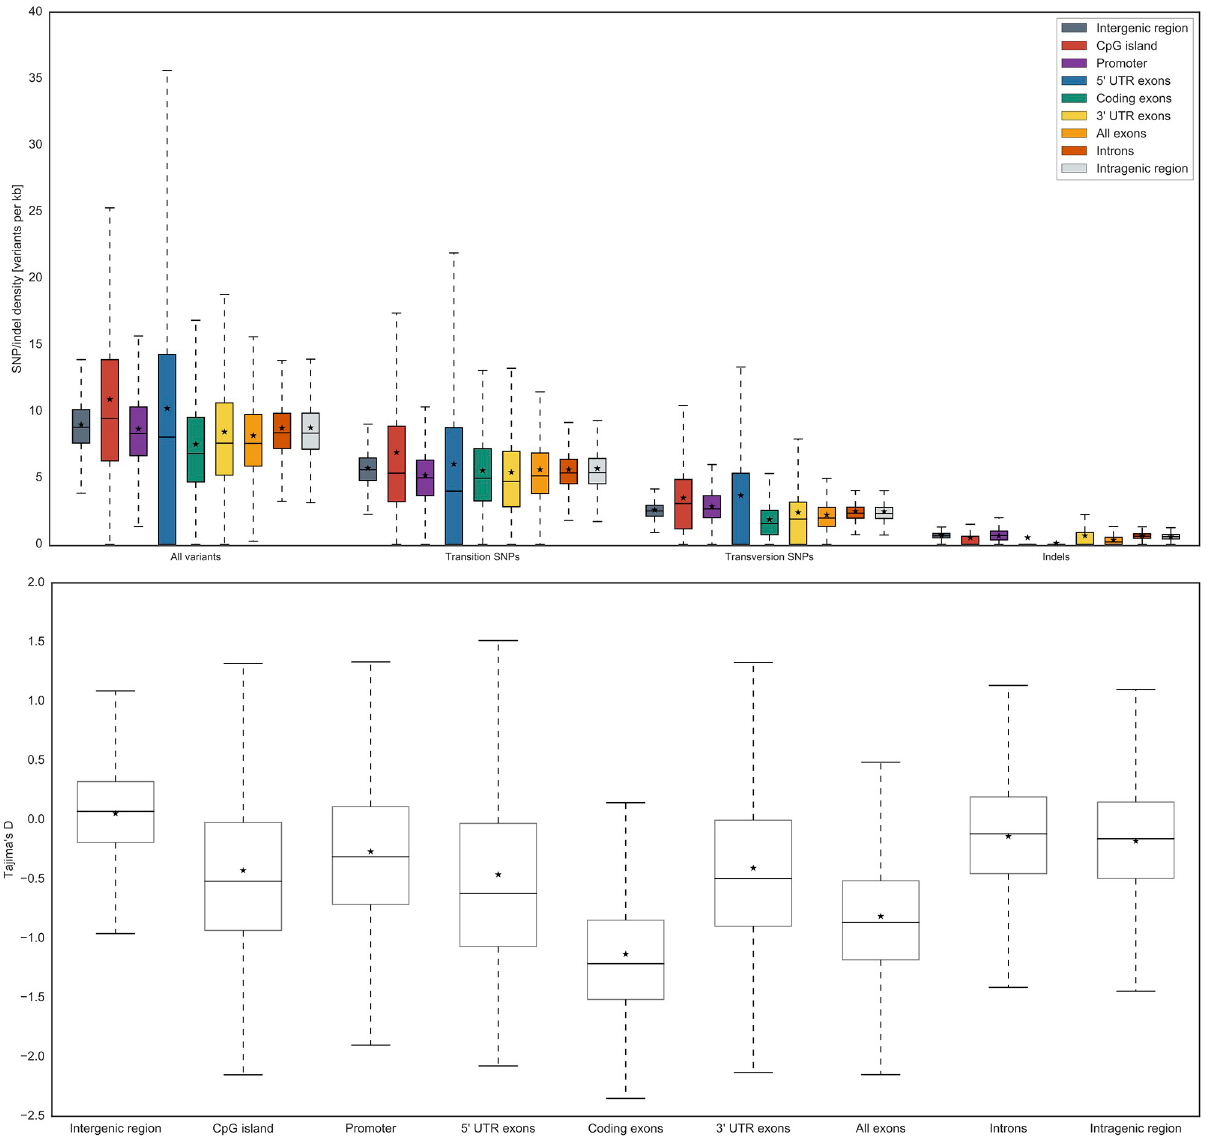
Fig 3. SNP and indel densities for all variant types and genomic elements considering 1000G data (European cohort). Upper panel: distribution of SNP and indel densities, the horizontal line ( − ) represents the median value, the asterisk ( ? ) denotes the mean value. In total, the 1000G European super population comprises 503 individuals; Lower panel: Tajima’s D statistic was applied to evaluate the neutral evolution hypothesis.